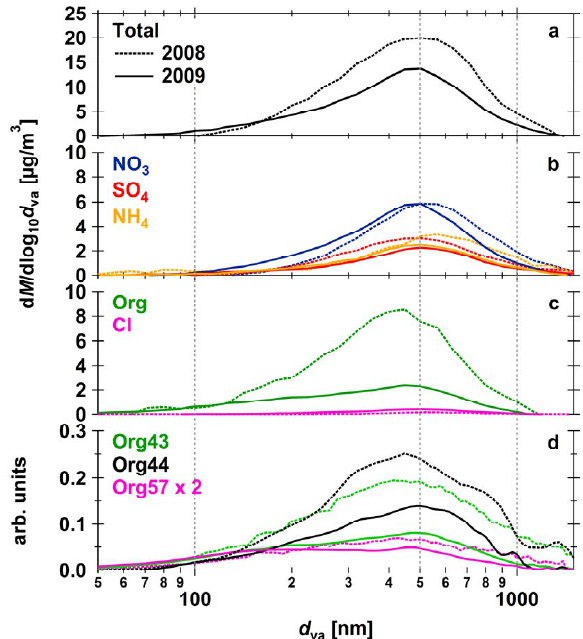
Fig. 8. Average size distribution for May 2008 (dashed lines) and Figure 8: Average size distribution for May 2008 (dashed lines) and March 2009 (solid lines) 3 March 2009 (solid lines) of the total mass (black, panel a ), ni- of the total mass (black, panel a), nitrate, sulfate, and ammonium (blue, red, and orange, 4 trate, sulfate, and ammonium (blue, red, and orange, respectively, respectively, panel b), organics, and chloride (green, and purple, respectively, panel c). Panel 5 panel b ), organics, and chloride (green, and purple, respectively, d shows the average size distributions of organic signal on m / z 43, m / z 44, and m / z 57 (Org43 6 panel c ). Panel d shows the average size distributions of organic (green), Org44 (black), and Org57 (purple), respectively, panel d). Note, that the signal of 7 signal on m/z 43, m/z 44, and m/z 57 (Org43 (green), Org44 (black), Org57 is multiplied by a factor of 2 for better display. 8 and Org57 (purple), respectively). Note, that the signal of Org57 is multiplied by a factor of 2 for better